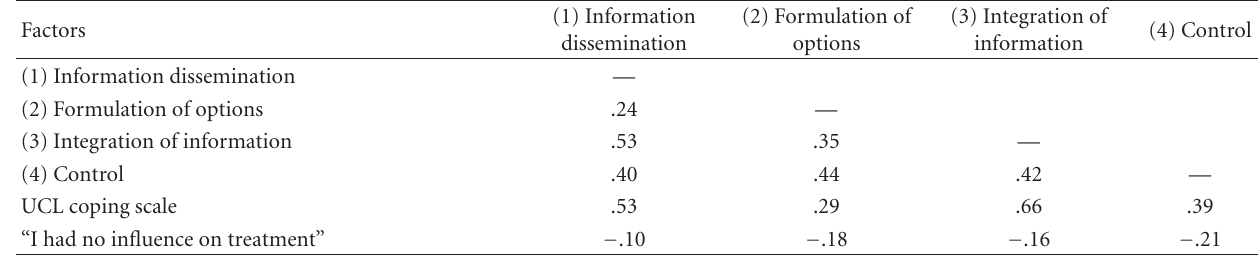
Table 6: Pearson correlations among the four factors and related